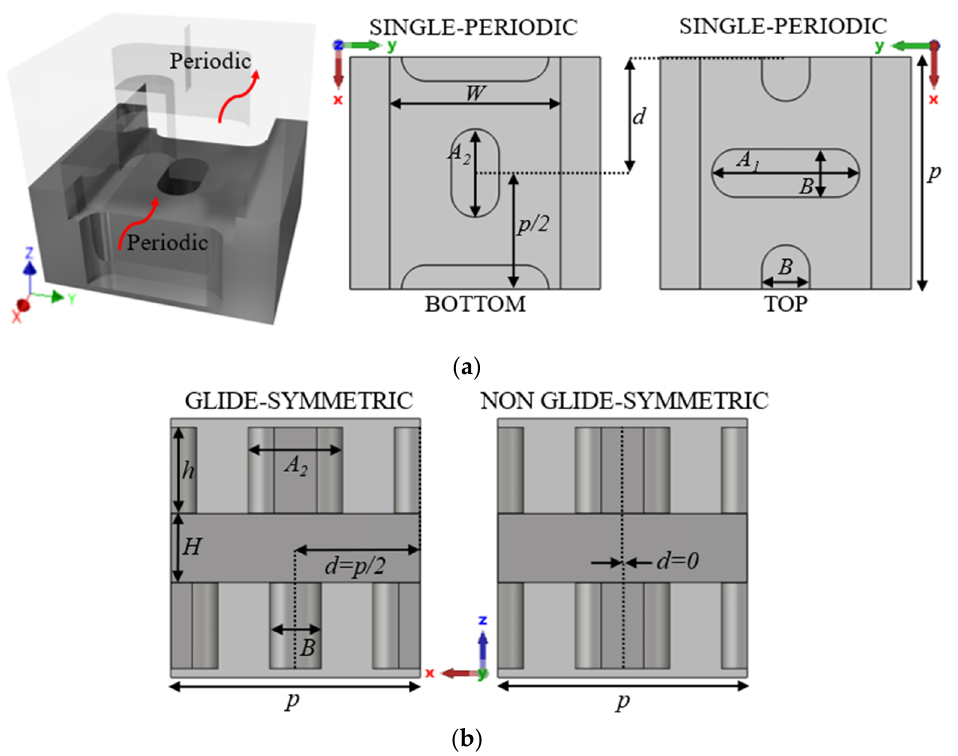
Figure 16. Double periodicity ideal unit cell. ( a ) Perspective, bottom and top views and ( b ) lateral view in glide and non-glide symmetric positions. Periodic in x -direction.